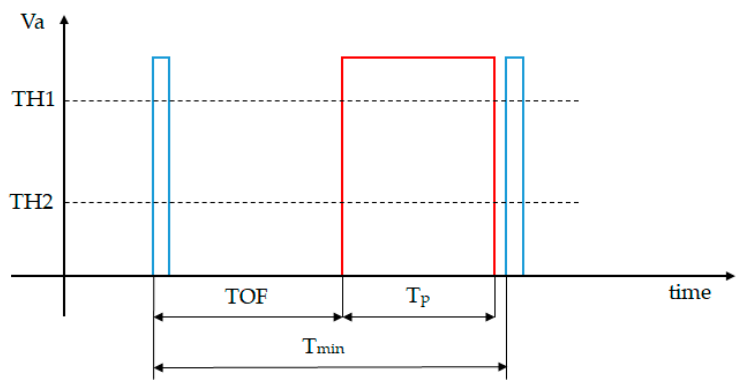
Figure 2. Synchronization of START and STOP pulses for time-of-flight [8]. The operating frequency has the following formula: